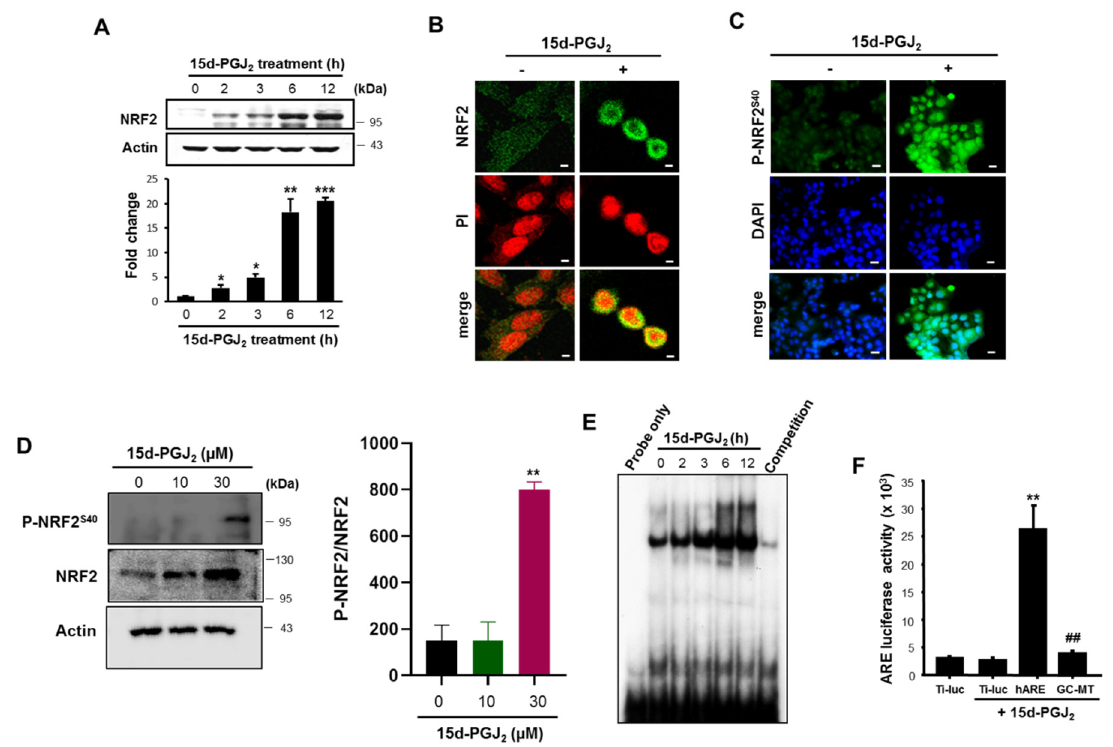
Figure 2. 15d-PGJ 2 induces nuclear translocation and antioxidant responsive element (ARE) binding of NRF2. ( A ) The level of nuclear NRF2 was assessed by Western blot analysis. Data are means ± SD. * p < 0.05, ** p < 0.01, and *** p < 0.001, significantly different compared to control. ( B ) Immunocytochemical analysis was performed using anti-NRF2 antibody after the treatment of MCF-7 cells with 30 µM 15d-PGJ 2 for 12 h. Cells were stained with propidium iodide (PI) and visualized by confocal microscopy. Scale bars indicate 50 µm. (C ) Immunocytochemical detection of phosphorylated Nrf2 in MCF-7 cells with 30 µM 15d-PGJ 2 for 24 h. Cells were also stained with 4 ′ ,6-diamidino-2-phenylindole (DAPI) to identify the nuclei (blue). Scale bars indicate 200 µm. ( D ) The phosphorylation of NRF2 was assessed by Western blot analysis. The experimental conditions are same as (C). ( E ) The ARE binding activity was measured by electrophoretic mobility shift assay (EMSA). Nuclear extracts were isolated after treatment with 30 µM 15d-PGJ 2 for indicated time periods. ( F ) For the comparison of transcriptional activity of NRF2, cells were transiently transfected with plasmid (ARE-Luc) harboring the ARE-binding site-luciferase construct, GC mutant ARE (GC-MT), or control vector (Ti-Luc). After overnight transfection, cells were exposed to 30 µM 15d-PGJ 2 for 12 h and treated with reporter lysis buffer for the measurement of the luciferase